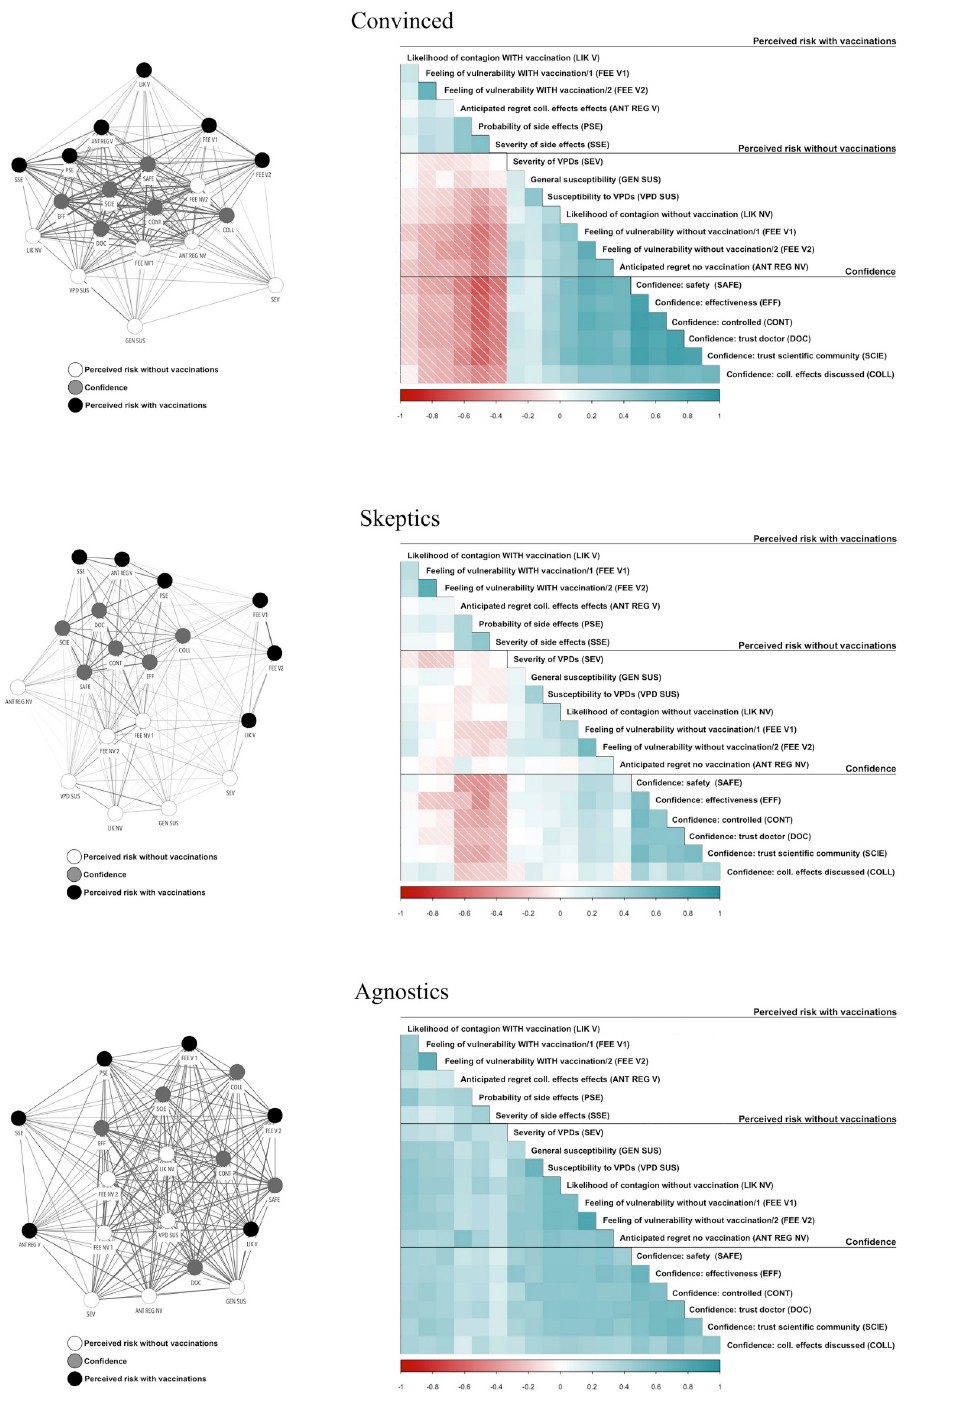
Fig 1. Belief networks in each group detected by RCA. In left-side network plots, each node corresponds to one variable, and each line connecting two nodes to the correlation between them, only if significant at a p � 0.05. Line shades and widths are proportional to the strength of the correlation. Given the complexity of the graph, only positive correlation lines are drawn. Networks are drawn using Fruchterman-Reingold algorithm, so that distances between the nodes inversely correspond to the edge weights connecting them. On the right side, the respective correlation matrices are reported. Light blue squares represent positive correlations and red-shaded squares negative correlations. The correlation coefficient is proportional to the intensity of the respective